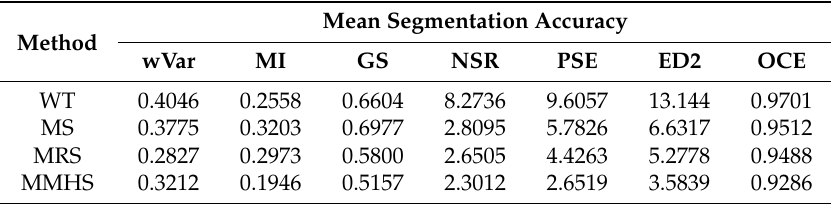
Figure 16. Mean segmentation accuracy histogram of wVar, MI, GS, NSR, PSE, ED2, and OCE for WTS, MS, MRS and MMHS. Table 12. The mean quantitative assessment results of T1–T6.